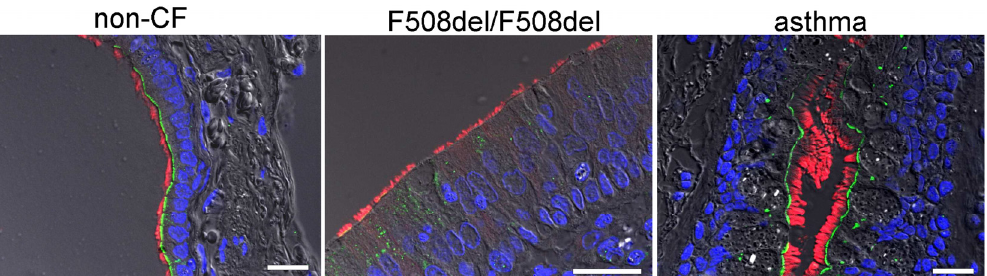
Figure 3. SLC26A9 is located in the apical membrane of ciliated airway epithelial cells. Immunocy- tochemistry of SLC26A9 (green) and acetylated tubulin (red) in superficial airway epithelium from a non-CF patient, a CF patient (F508del-CFTR/F508del-CFTR) and an asthma patient. SLC26A9 is exclusively localized in the apical membrane of ciliated airway epithelial cells in non-CF and asth- matic lungs but not in CF-lungs from patients carrying the F508del-CFTR/F508del-CFTR mutation. Bar = 50 µm. Nuclei were stained by DAPI.